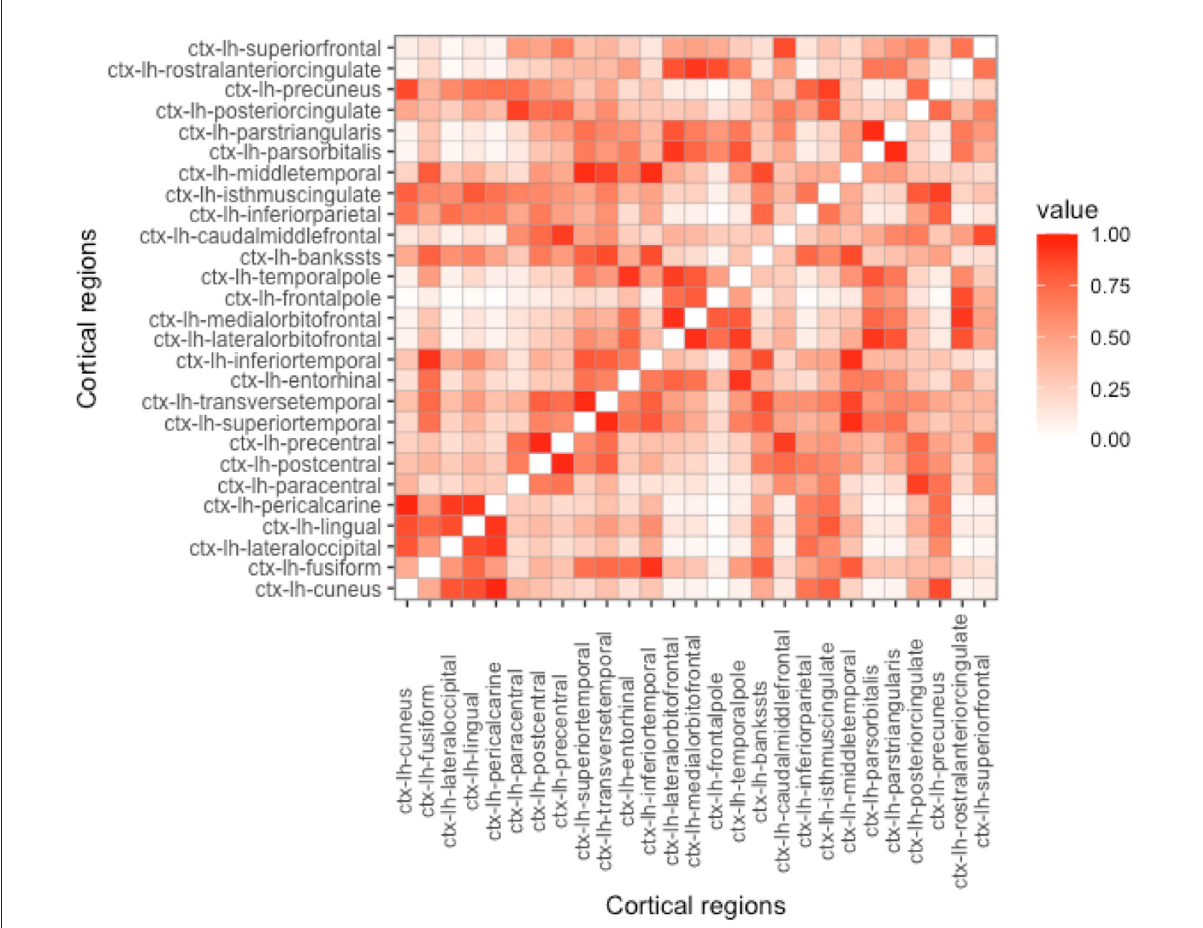
FIGURE2 Proximity matrix displayed for the left hemisphere, Euclidean distance, and parameter h the Supplementary